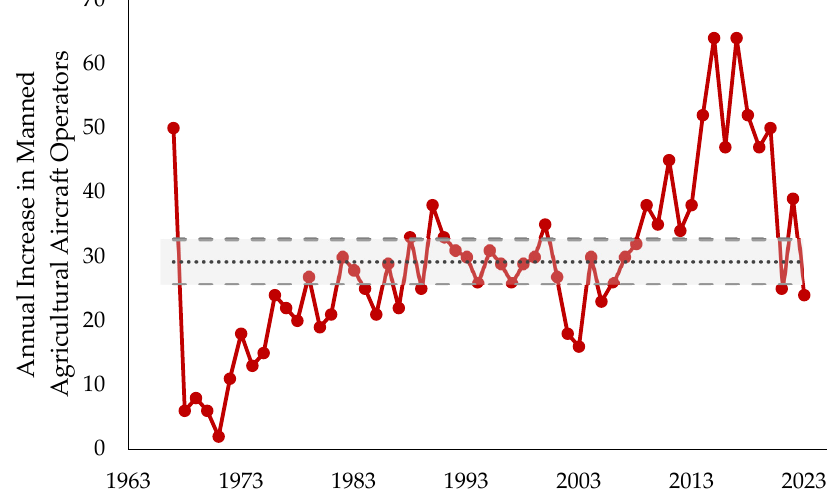
Figure 2. The annual increase in manned agricultural aircraft operators. The average annual increase is 29.3 (black dashed) with a 95% confidence interval of 25.8–32.7 (dashed grey).